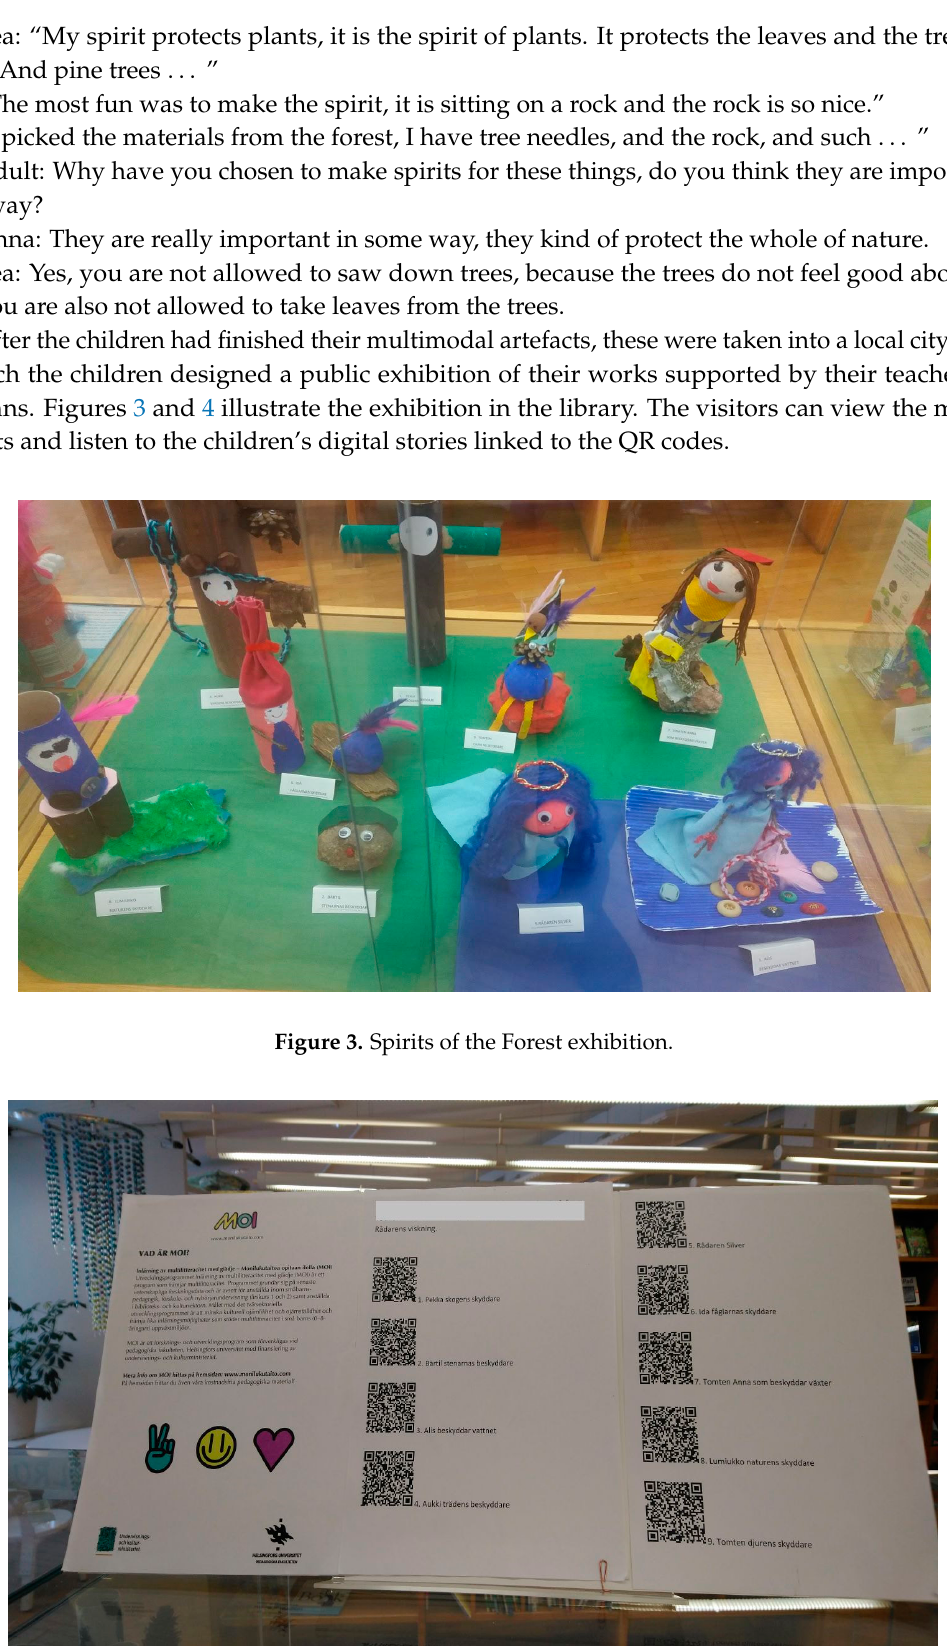
Figure 4. Digital stories of the Spirits of the Forest.